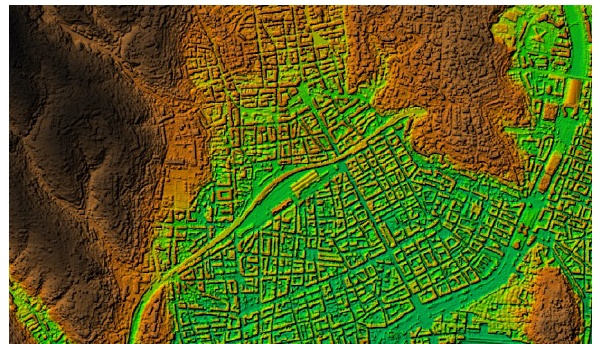
Figure 11. Example of CO3D Digital Surface Model (Nice downtown)